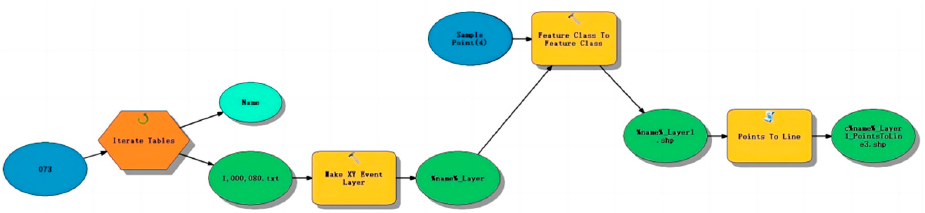
Figure 3. Motion trajectories in ArcGIS software.